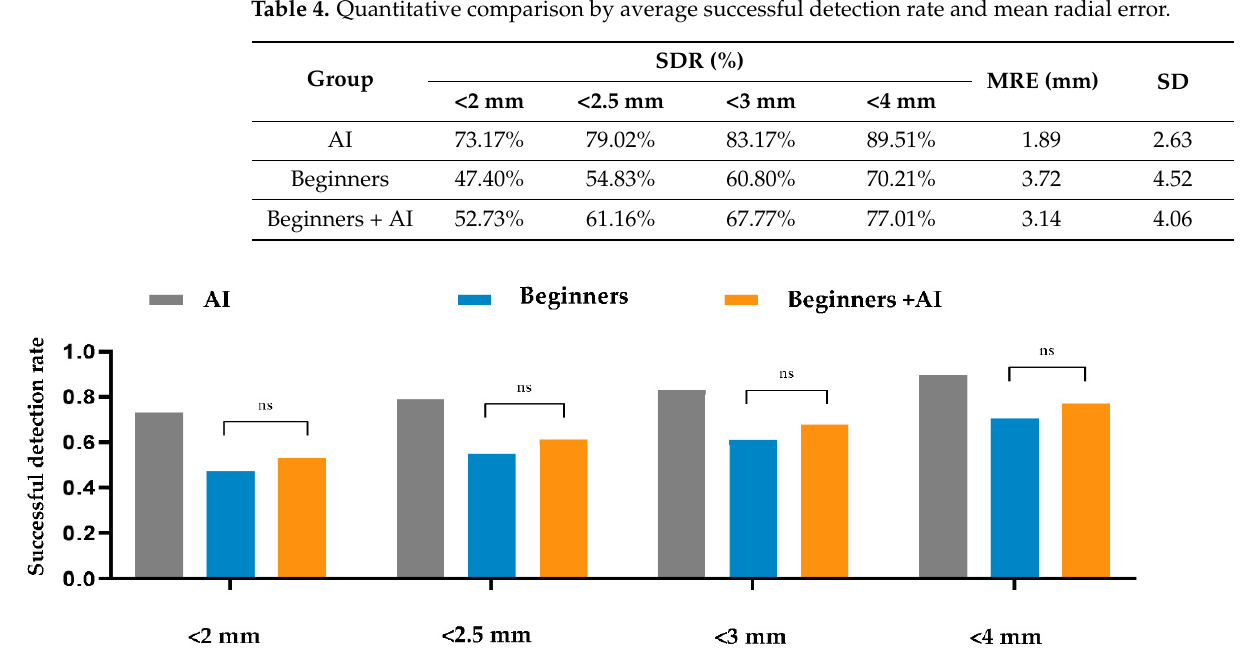
Figure 2. Comparison between the beginner-only and beginner–artificial intelligence groups in terms of the successful detection rate. A t-test was applied to compare the average successful detection rates between the beginner-only and beginner–AI groups within 2, 2.5, 3, and 4 mm thresholds. The beginner–AI collaboration improved the successful detection rates within 2, 2.5, 3, and 4 mm thresholds. Abbreviations: AI, artificial intelligence; ns, not significant.